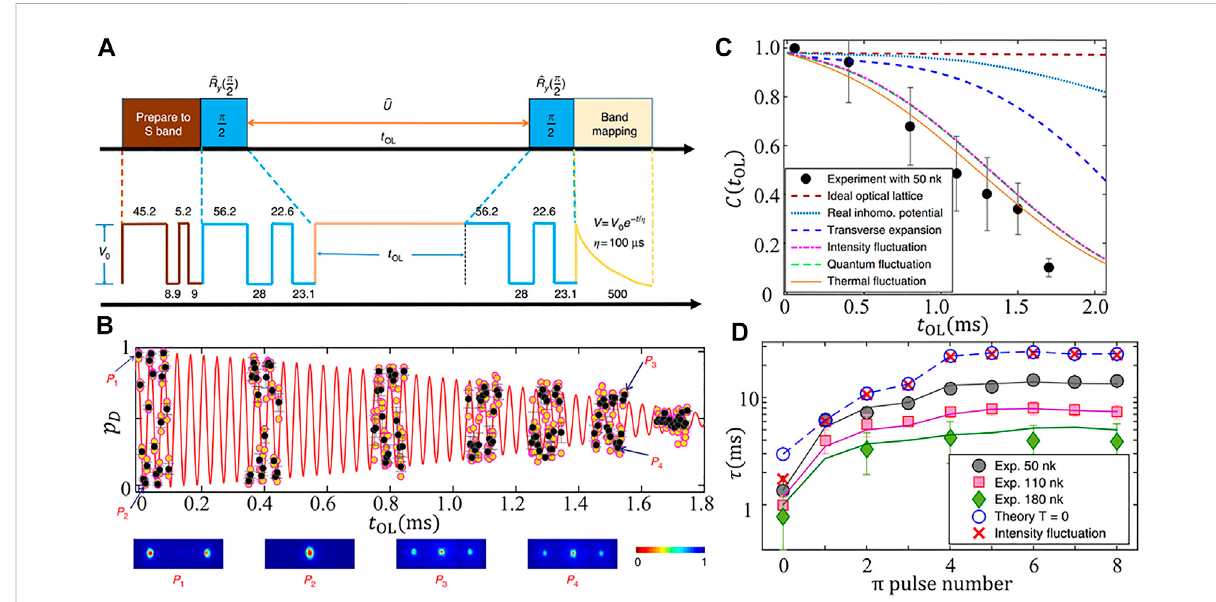
FIGURE 9 (A) Time sequences for the Ramsey interferometry. The atoms are fi rst loaded into the S-band, followed by the RI sequence π /2-pulse, holding time t OL ,andthesecond π /2-pulse.Finally,bandmappingisusedtodetectthenumberofatomsinthedifferentbands.Theusedsequencesdesigned by the shortcut method are shown in the fi gures (unit: μ s). (B) The oscillation of the population of atoms in the D-band p D . The images below show typical time of fl ight pictures after band mapping. (C) The experimental contrast (black points) and the theoretical calculation for V 0 = 10 E r . In theory, we begin with an ideal optical lattice and gradually add the effect of lattice inhomogeneity, transverse expansion of atom cloud, intensity fl uctuation of laser amplitude, quantum fl uctuation, and thermal fl uctuation. (D) Coherence time τ vs the number of applied π -pulse n with different